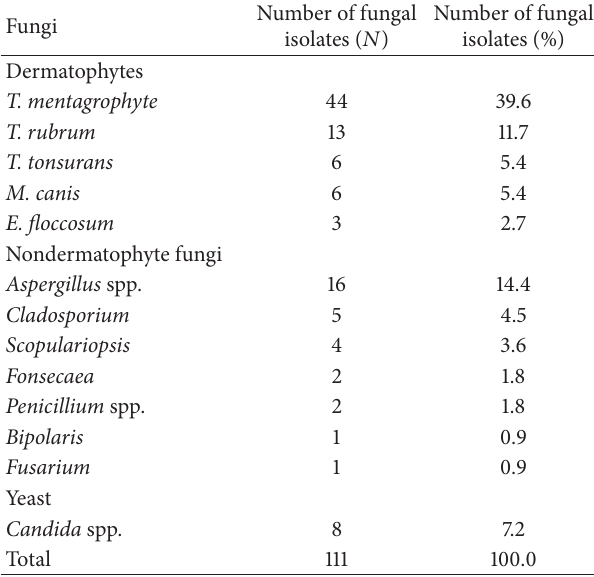
Figure 6: Microscopic view of Fusarium spp. (LPCB mount, 400x). Table 2: Frequency of fungal isolates growth ( 𝑁 = 111